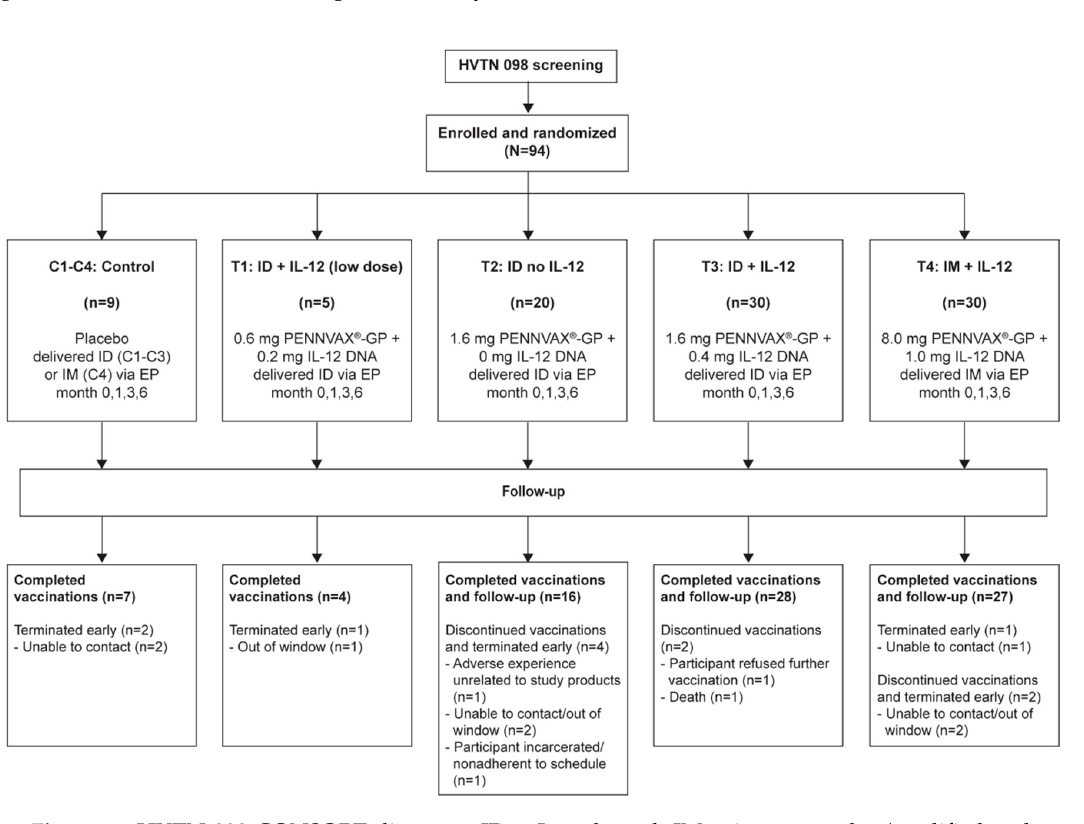
Figure 1. HVTN 098 CONSORT diagram. ID = Intradermal; IM = intramuscular (modified and reproduced with permission from [22].